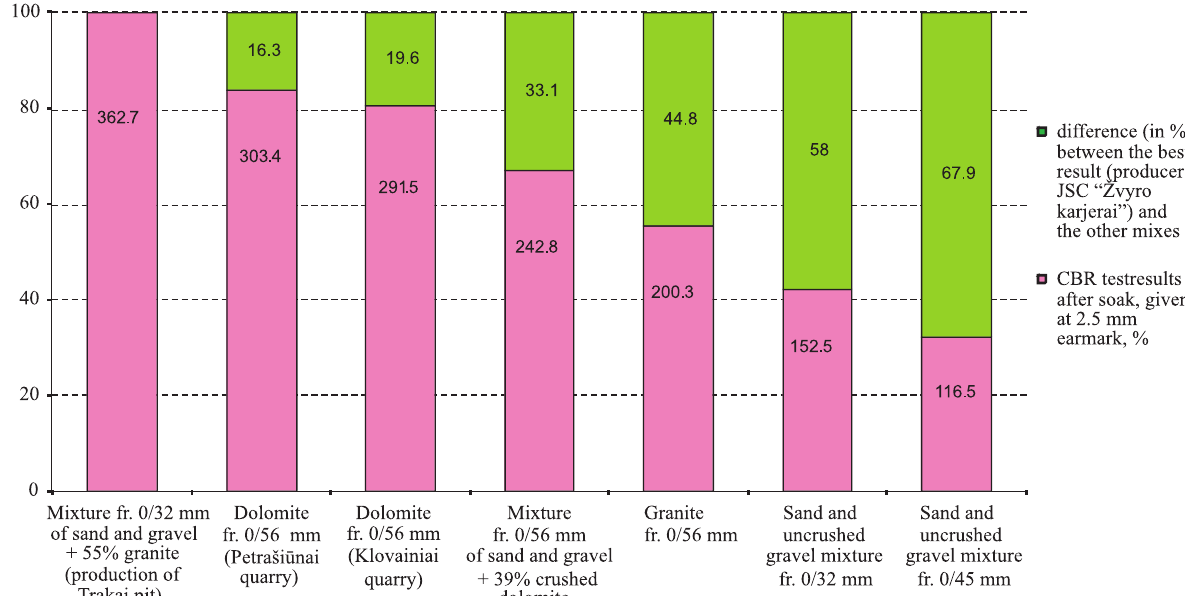
Fig. 4. Comparison of different producers and different road base mixtures according to CBR value after